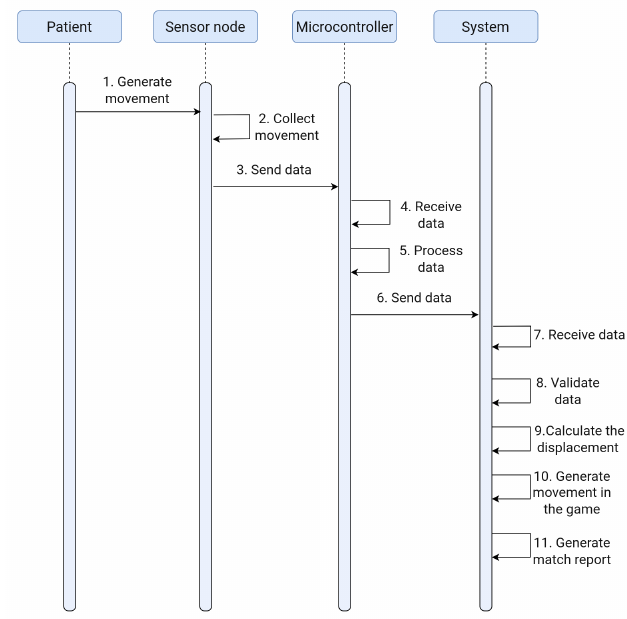
Figure 5. Solution sequence diagram. Source: Author (2022).